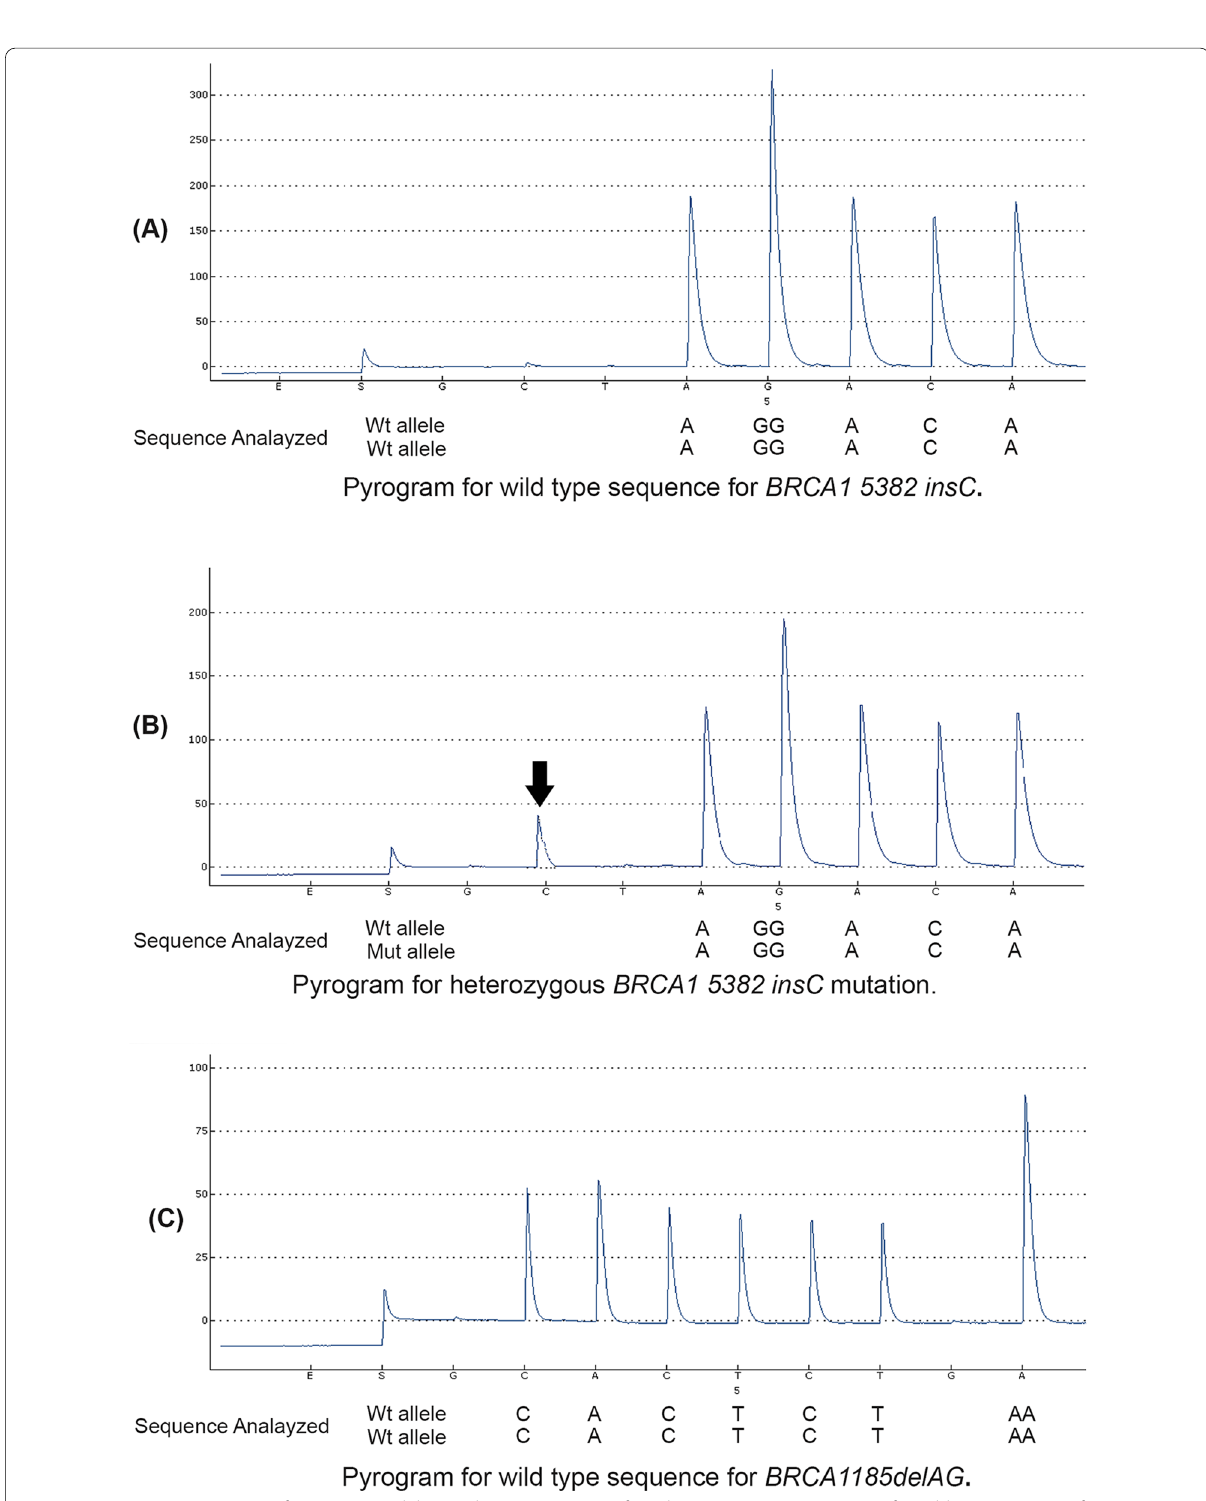
Fig. 2 Representative pyrogram for BRCA1 185delAG and BRCA1 5382 insC founder mutation. A , B Pyrogram for wild‑type sequence for BRCA1 5382 insC. B Pyrogram for heterozygous BRCA1 5382 insC mutation in a carrier FOC patient (case number 1). At position 2 there is an insertion of extra C. Negative internal controls were obtained by negative nucleotide dispensation of G unit at position 1 and T unit at position 3. C At the wild‑type sequence for BRCA1 185delAG, the generated peak heights for nucleotide dispensations at positions 2, 3, 4, 5, 6, and 7 (CAC TCT in the reverse strand) are approximately equivalent and represent incorporation of a single nucleotide in both alleles (2 light units), but the signal intensity of A at position 9 is two times greater (4 light units) and reflects the incorporation of two as in tandem in both